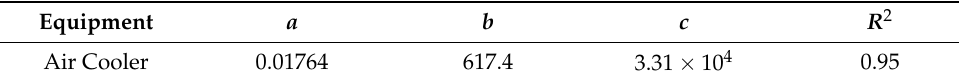
Table 3. The coefficients of Equation (3) for air coolers.